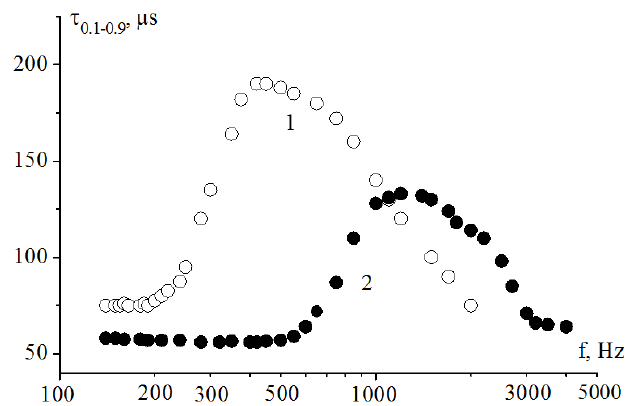
Figure 6. Frequency dependencies of the electro-optical response time for the HF32D composition ( γ ϕ = 0.15 Poise). 1—amplitude of the bipolar voltage (meander) ± 1.5 V; 2—amplitude ± 9 V. The thickness of the electro-optical cell is 1.7 μm.